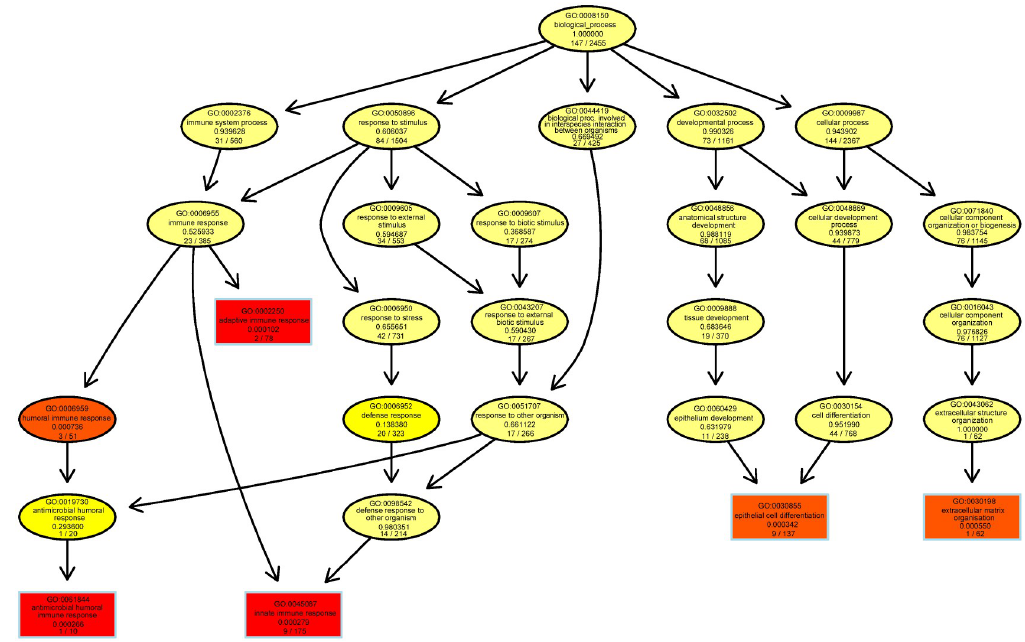
Fig 2. Example DAG of GO terms with GSEA on GSE12685 dataset of AD. The original graph (on the top) and a zoom (on the bottom) are presented. The 5 most significantly enriched GO terms are indicated by the rectangles and the oval shaped nodes represent significant GO terms. The red and orange colors indicate the most significant GO terms. The last two lines inside each node show raw p-value followed by the number of significant genes and the total number of genes annotated to the corresponding GO term for the